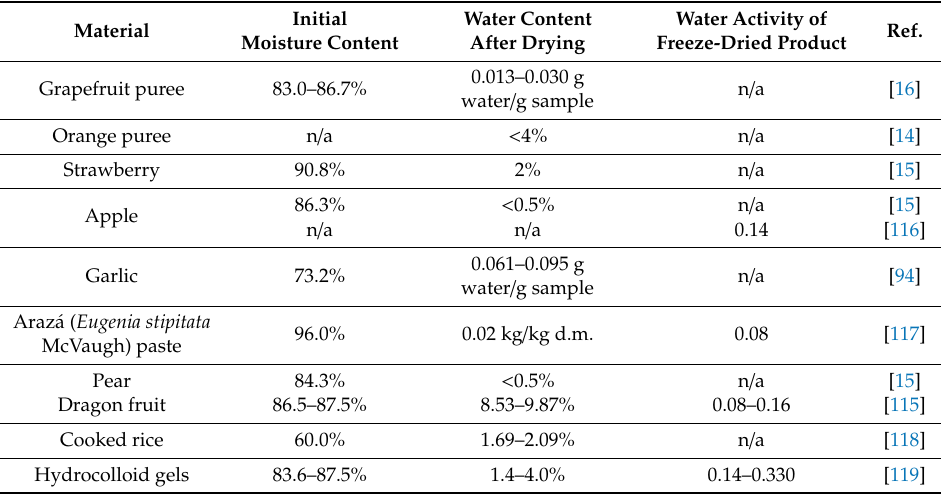
Table 1. Water activity and moisture content of selected freeze-dried